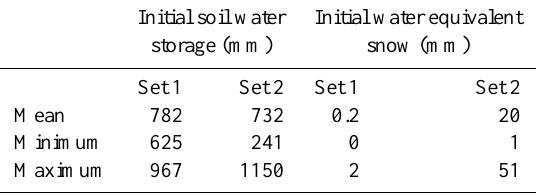
Table 2. Mean, 10th and 90th percentile of seasonally averaged λE / R n from SEBAL and HTESSEL for both the initial condition Set 1 and Set 2 using a spatial resolution of 25km. The RMSE of the HTESSEL model predictions is given in the last